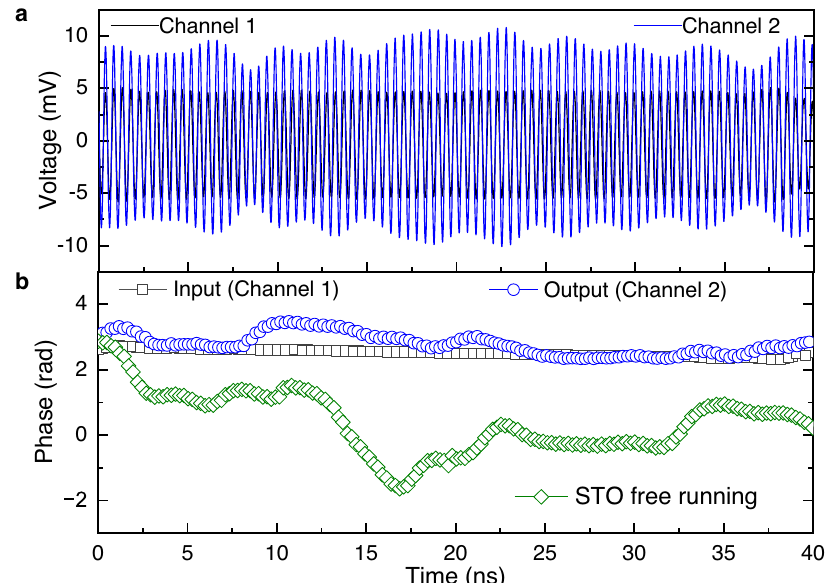
Fig. 3 | The time domain scheme and measurements. a Time-resolved voltage tracesoftheinputsignalinchannel1(blackline),andtheoutputsignalinchannel2 (blueline).Notethatwenumericallyapplieda600MHzband-pass fi ltercenteredat peak frequency (2.1GHz) to eliminate the background noise, low-frequency noise,